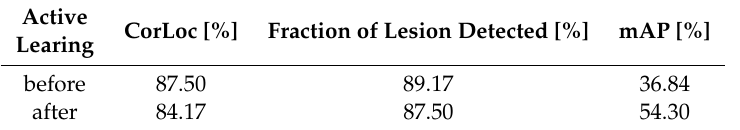
Table 6. Results showing the effect of active learning in the Stanford Dog